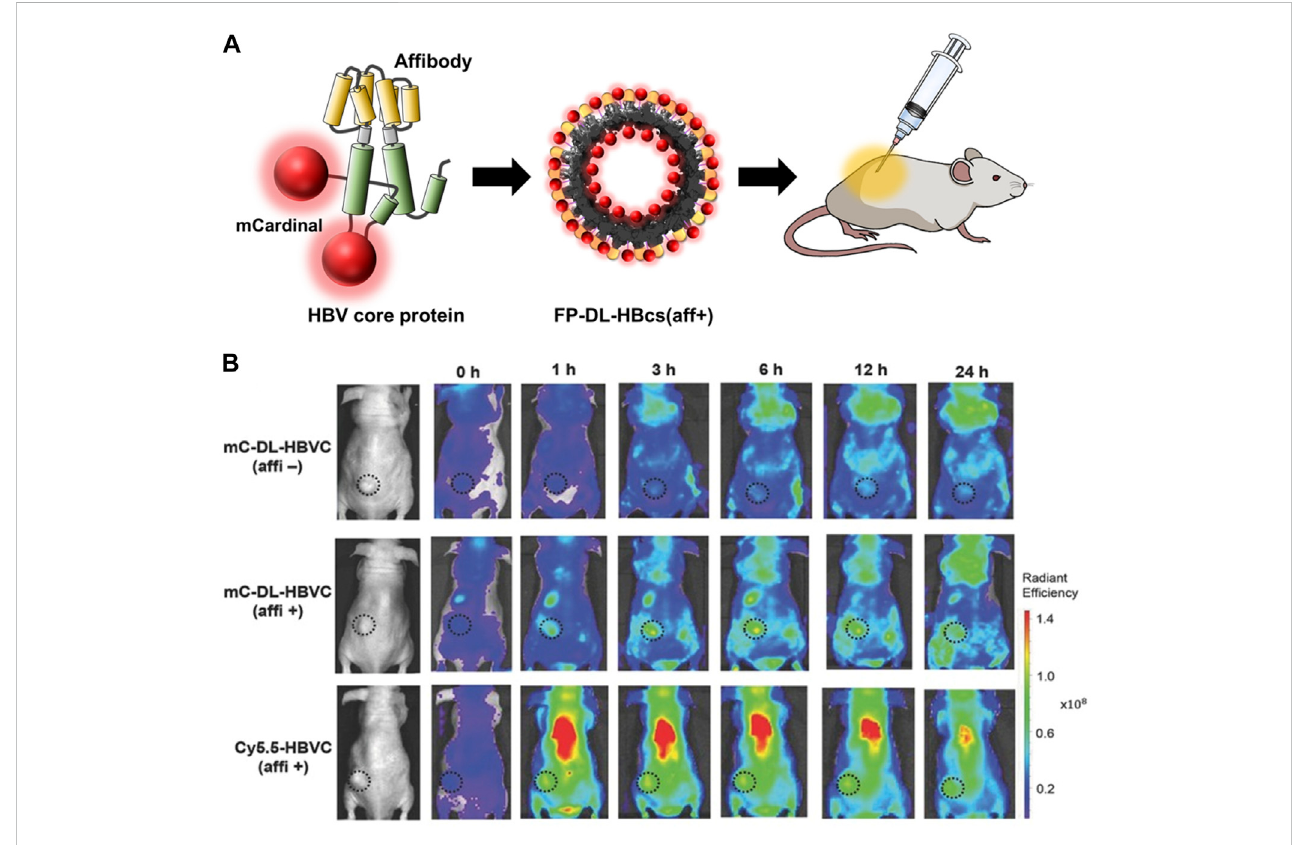
FIGURE 7 (A) Schematic diagram of the preparation of FP-DL-HBcs for bio-imaging of cancer cells. (B) NIR fl uorescence images of MDA-MB-468 tumor-bearing mice after the intravenous injection of FD-DL-HBcs (Kim et al.,